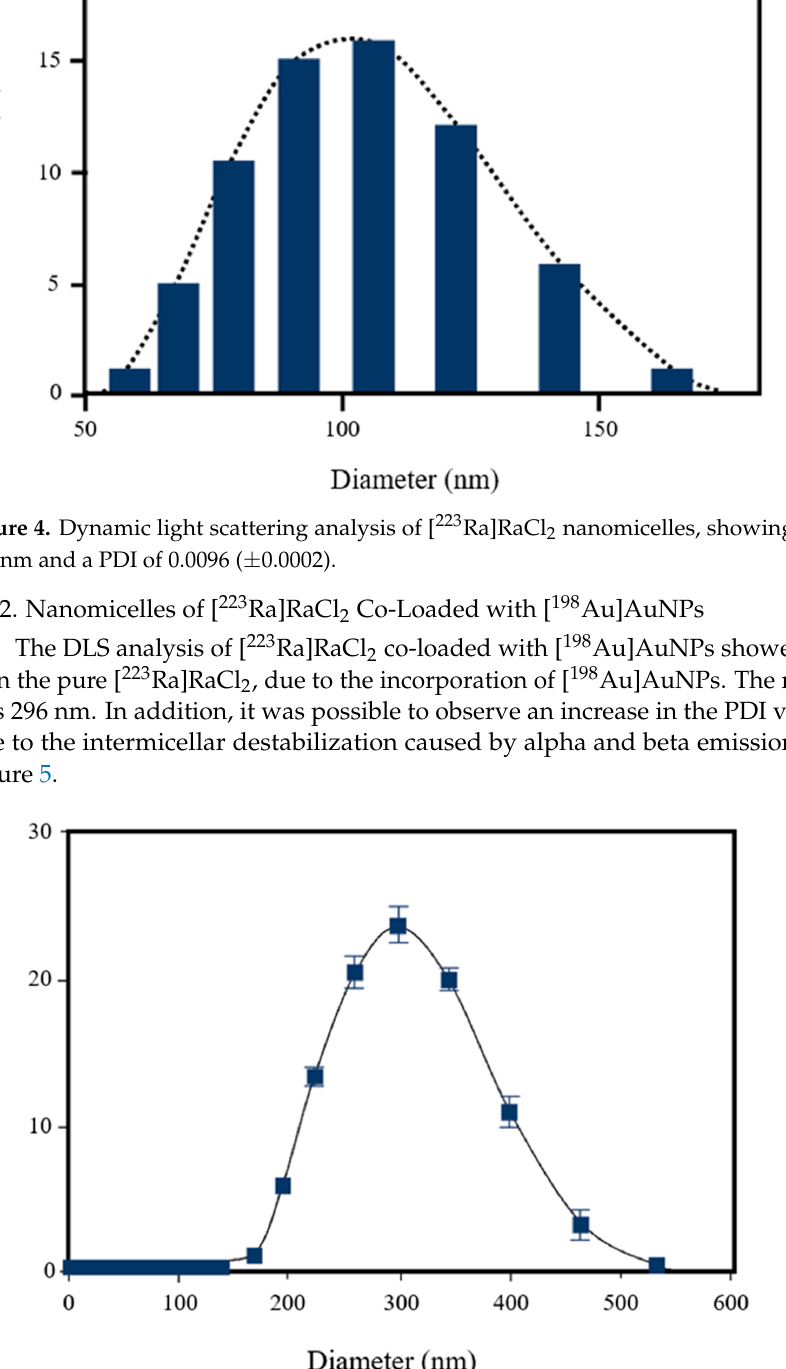
Figure 3. Topographic AFM image of [ 198 Au]AuNPs. ( A ) Heightmap of AuNPs cluster and ( B ) its respective three-dimensional visualization. ( C ) Cross section over the AuNPs in the corresponding region, highlighted in image ( A ) (dotted line in light blue). The particle diameter observed in the AFM measurements is compatible with the values observed in the DLS measurements.